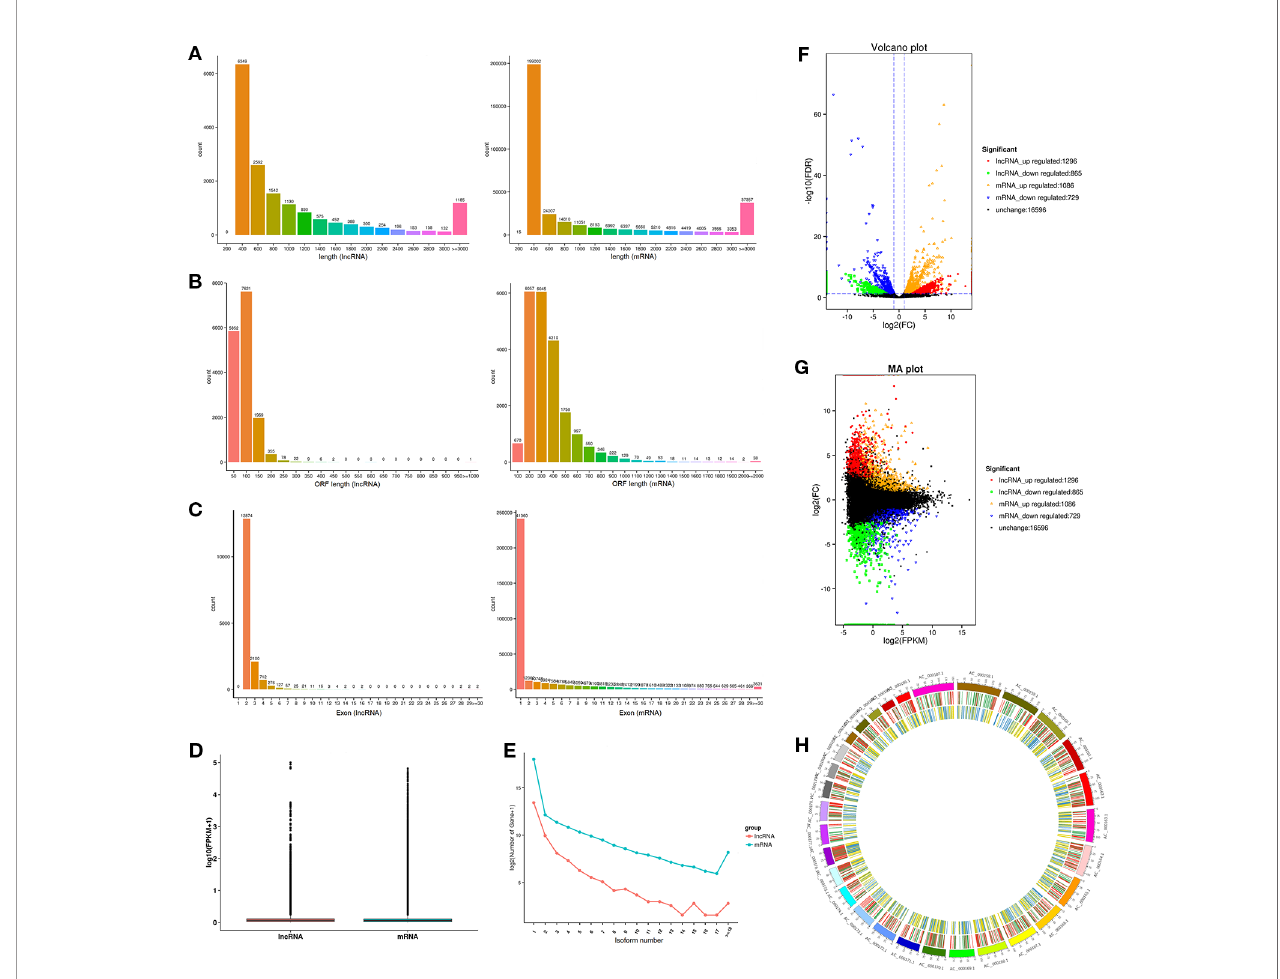
FIGURE 4 | Comparison and analysis of genomic features of mRNA and lncRNA in muscle tissue. (A) Distribution of transcript lengths of lncRNAs and mRNA. (B) Distribution of ORF lengths of lncRNAs and mRNA. (C) Distribution of exon number of lncRNAs and mRNA. (D) Distribution of expression levels of lncRNAs and mRNA. (E) Distribution of isoform number of lncRNAs and mRNA. (F , G) Volcano plot and MA interactive maps showing the correlation between abundances of differentially expressed lncRNAs and mRNA. (H) Distribution of differentially expressed lncRNAs along each